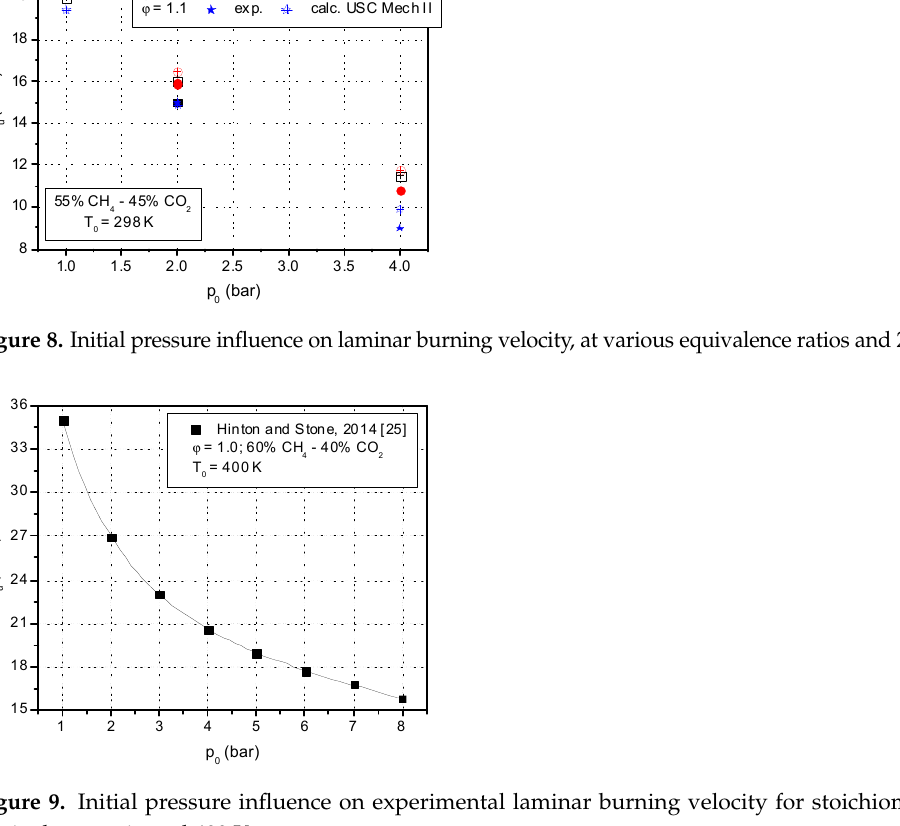
Figure 11. Initial temperature influence on experimental laminar burning velocity, at various equivalence ratios and 1 bar initial pressure. 6.2. Effect of Hydrogen Addition on the Laminar Burning Velocity of Biogas-Air Flames Because the biogas has a low heating value, some studies have turned their attention to improve its relatively poor combustion characteristics. To improve the combustion properties of the biogas, it can be mixed with another combustible gas whose combustion properties, mainly the flame velocity, are greater. Given that, the hydrogen, which is a high-quality fuel with zero greenhouse potential, was chosen by some researchers to be added to biogas. The results showed a higher heat release rate, an improved stability of the flame and an increased flame temperature [42,111,112]. A significant improvement in combustion properties was observed by adding a trace amount of hydrogen into the bio- gas mixtures causing the acceleration of the reaction rate which counteracts the dilution effect of the large amount of CO 2 from biogas [111]. The experimental and numerical methods for obtaining the laminar burning velocity of biogas- H 2 -air mixtures presented in this work are summarised in Table 5. Table 5. Summary of experimental and numerical methods for obtaining the laminar burning velocity of biogas-H 2 -air mixtures presented in the present study. Type of Method